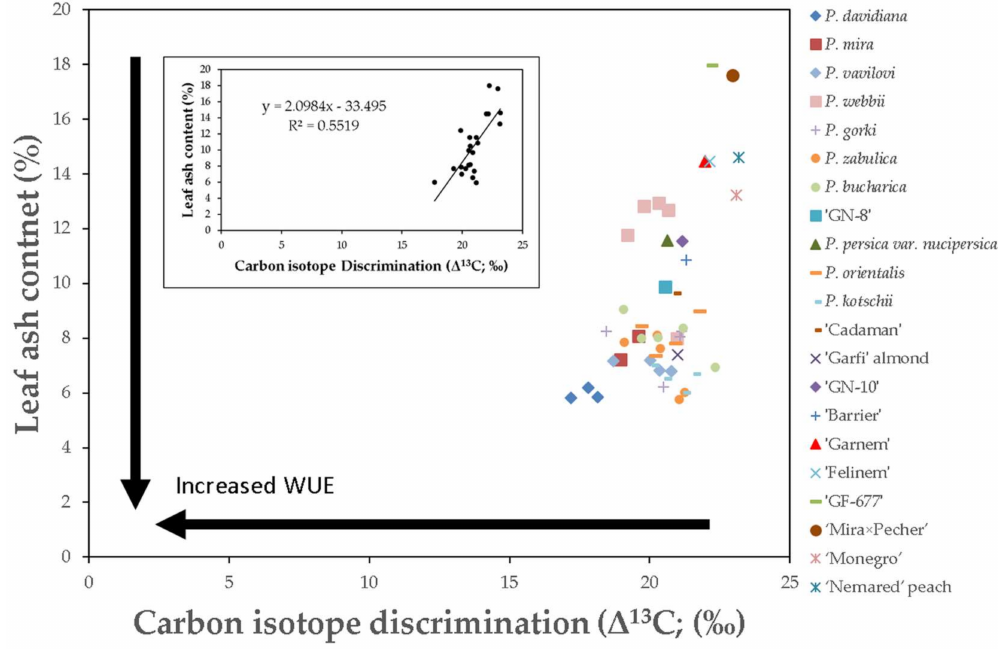
Figure 1. Relationship between carbon isotope discrimination [ ∆ 13 C ( ‰ )] and leaf ash content (%) for Prunus genotypes. Arrows indicate the negative relation between these two parameters and